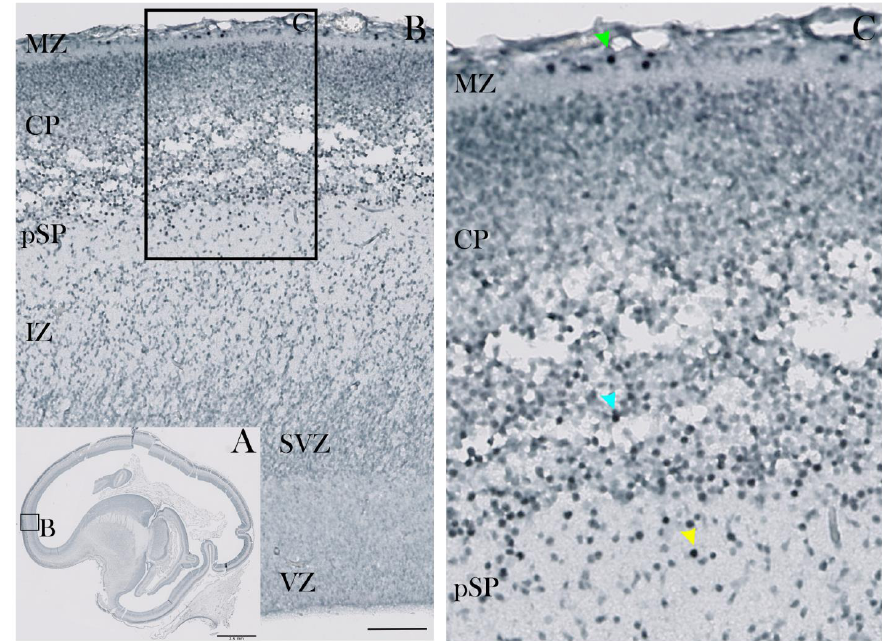
Figure 1. CUX2 is expressed in MZ, deep CP and pSP during the pre-subplate phase at 10 PCW. ( A ) Complete scan of the parasagittal section through the telencephalon of the human fetus immunostained for CUX2. ( B ) Higher magnification light microscopy images of box denoted in A showing developing neocortical wall from the surface-placed Marginal Zone (MZ) to proliferative Ventricular Zone (VZ). ( C ) Parasagittal section through the telencephalon of the human fetus at 10 PCW was immunostained for CUX2. ( C ) CUX2+ nuclei were found in the MZ the deep Cortical Plate (CP; blue arrowhead) and pre-Subplate (pSP; yellow arrowhead), with strongly reactive nuclei in the MZ (green arrowhead). SVZ, Subventricular Zone; IZ, Intermediate Zone. Scale bar = 100 µm ( A ).